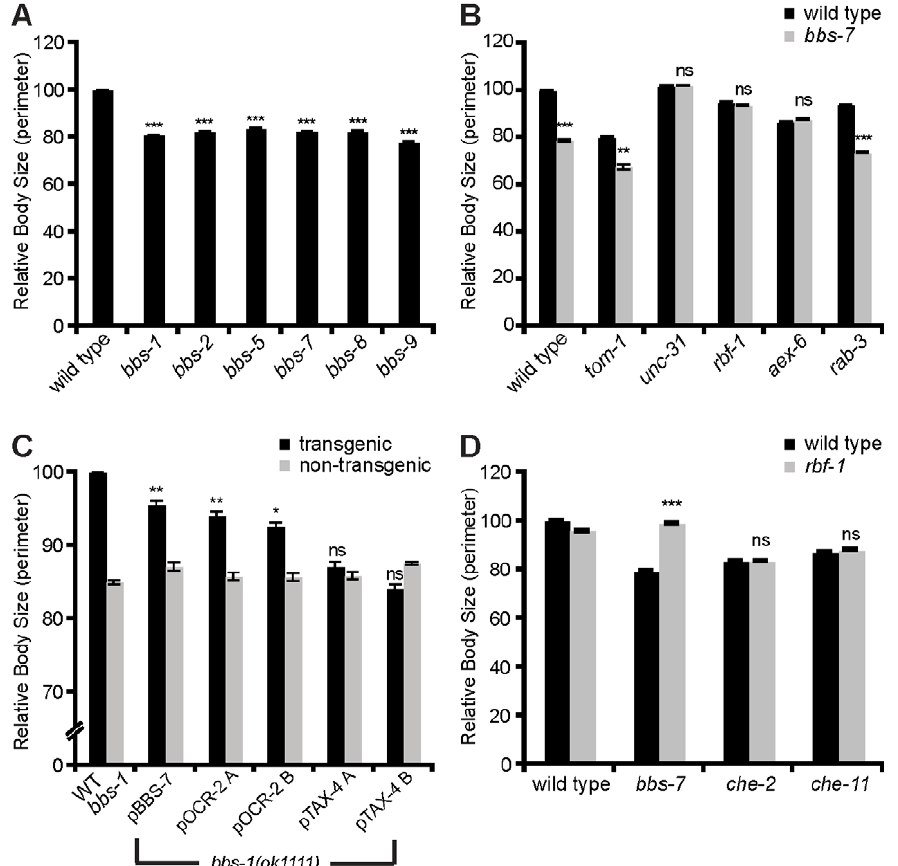
Figure 5. Hyperactive secretion causes small body size of bbs mutants. (A) Quantitation with standard error of body sizes of bbs mutants compared to wild type (*** p , 0.001). (B) Mutations that abrogate enhanced secretion ( rbf-1 , aex-6 , unc-31 ) normalize while loss of tom-1 further reduces the body size of bbs mutants (*** p , 0.001, ** p , 0.01; ns , not significant, comparing double mutants to the corresponding single mutant). (C) Quantitation with standard error of bbs-1 mutants expressing bbs-1 cDNA under the indicated neuron-specific promoters. Expression patterns of these promoters are listed in Table S1 (* p , 0.05, ** p , 0.01, *** p , 0.001, comparing transgenic animals to non-transgenic siblings). (D) Rabphilin, rbf- 1 , suppresses the body-size defect of bbs-7 but not of IFT mutants, che-2 and che-11 (*** p , 0.001; ns , not significant, comparing double mutant to bbs-7 or IFT single mutant).